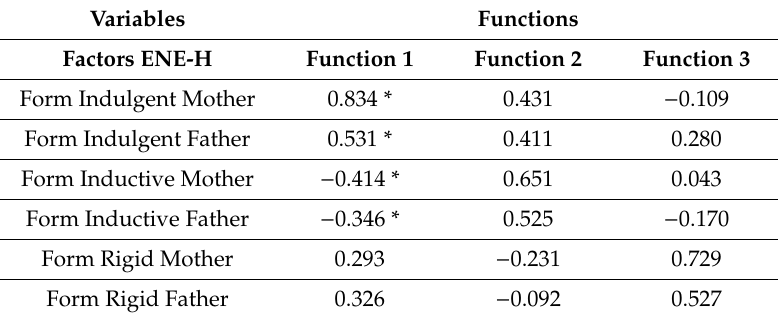
Table 4. Structure matrix. Variables ordered by the size of correlation with the discriminant function. Variables